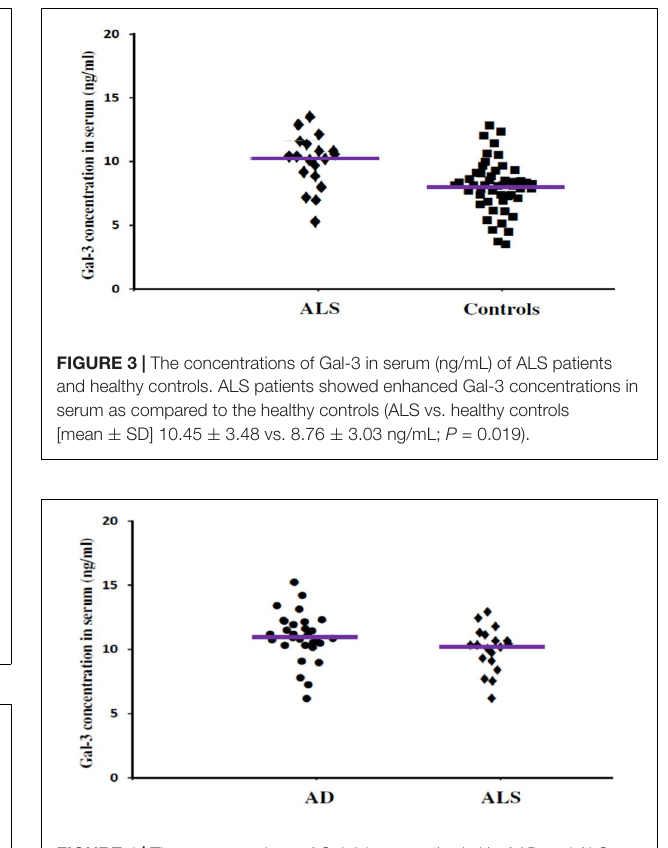
[AD vs. ALS (mean ± SD) 8.37 ± 2.79 vs. 7.92 ± 2.56 ng/mL;